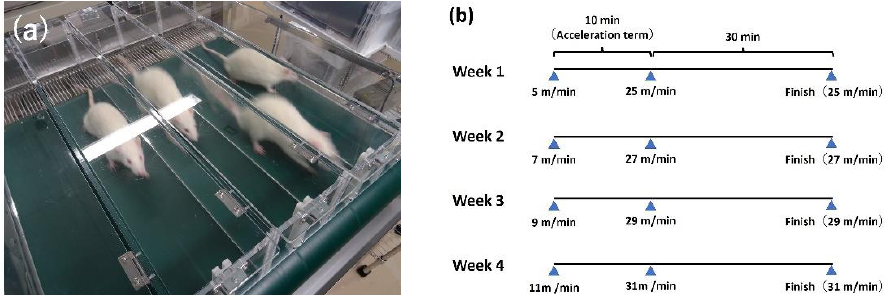
Figure 1. ( a ) Treadmill training; ( b ) protocol of treadmill training.